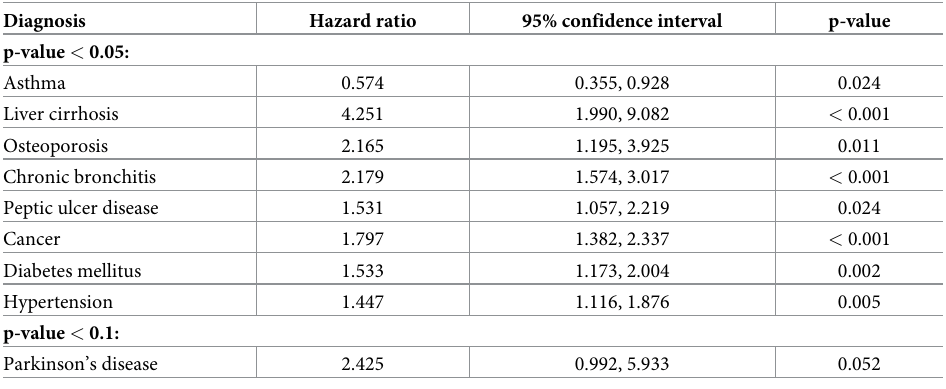
Table 6. Relation between diagnoses and survival time for diagnoses selected by the optimal